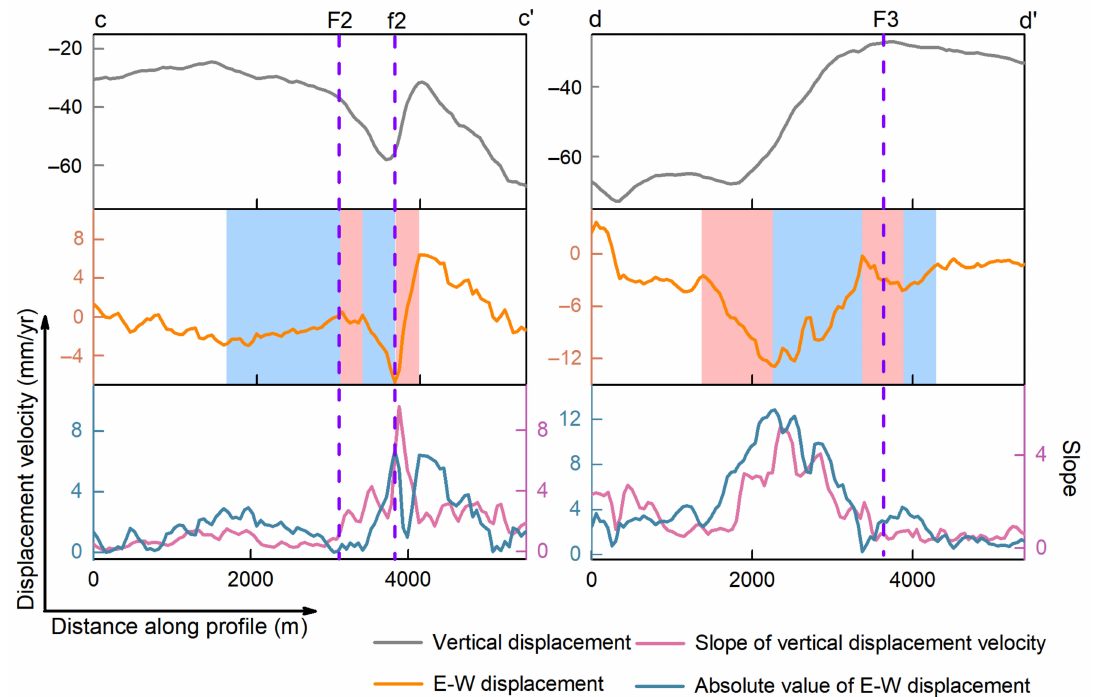
Figure 15. Vertical and east–west horizontal displacement rates (2016–2018) and displacement rate gradients along two profiles whose positions are marked in Figure 3. I, II, III, and IV are representative points on the profile. The brown dashed lines indicate the locations of ground fissures and faults. The unit of the slope is 10 − 3 ◦